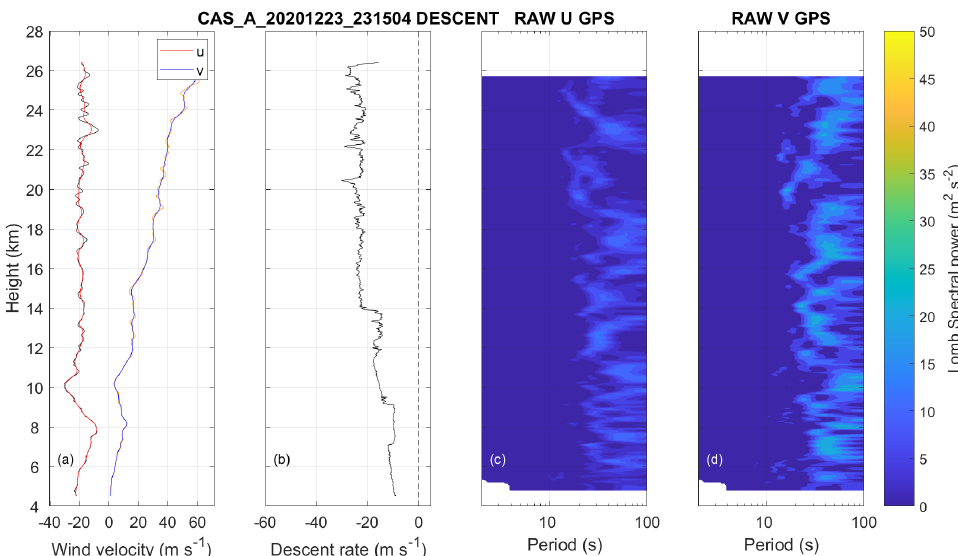
Figure 8. Vertical profiles of (a) processed horizontal wind components u and v in solid red and blue respectively with raw GPS winds in black and orange for the u and v components respectively, and (b) descent speed. Panels (c) and (d) show Lomb periodograms of the detrended raw GPS velocities as a function of height for a sounding made at Castor Bay autosonde station (54.50 ◦ N, 6.34 ◦ W) at 23:15UTC